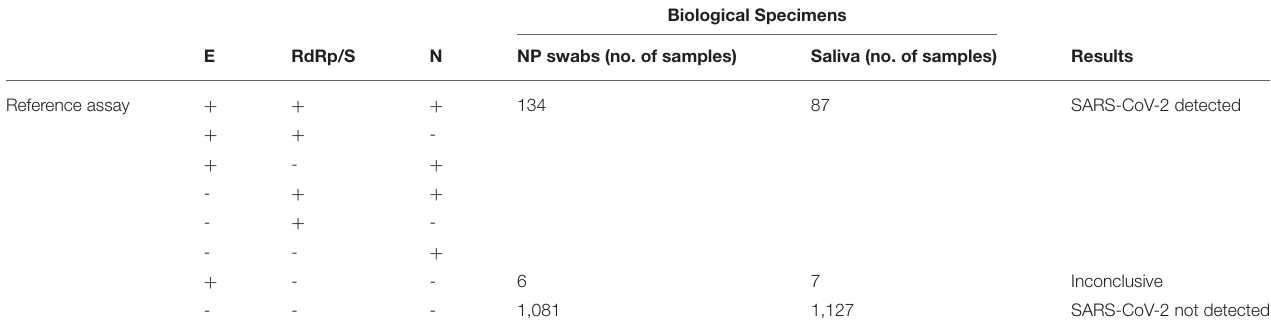
TABLE 1 | Summary of study results with the first reference diagnostic assay (Allplex 2019-nCoV—Seegene).